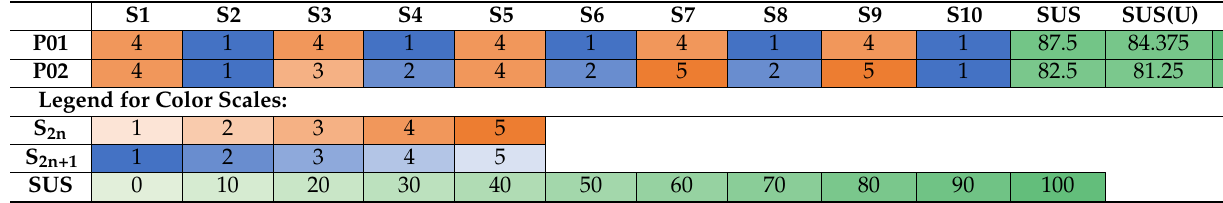
Table A4. Results of the application of the SUS questionnaire to two physiatrists at T0.